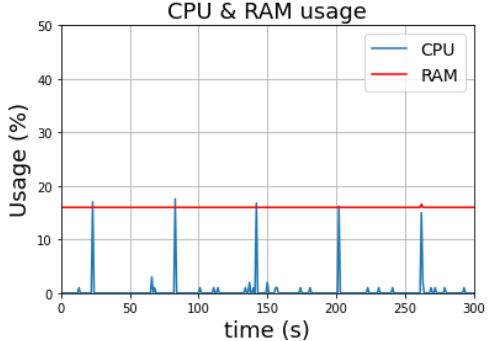
Figure 4. Data I/O for ChronoEOS 2.0.